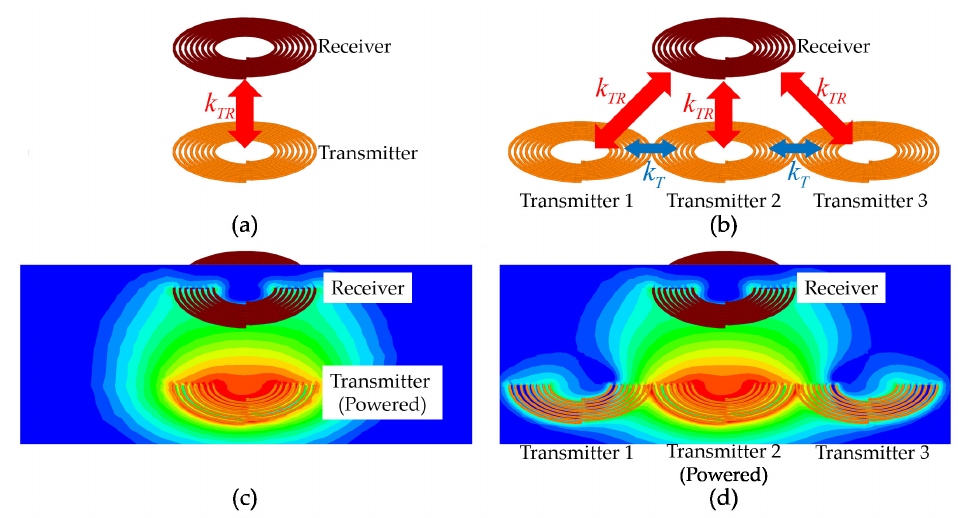
Figure 1. WPT configurations: ( a ) SISO-WPT, ( b ) MISO-WPT, ( c ) SISO-WPT with field analysis, and ( d ) MISO-WPT with field analysis (Transmitter 2 is powered, while other transmitters are power-off). Most of the studies above provided effective methods to eliminate the